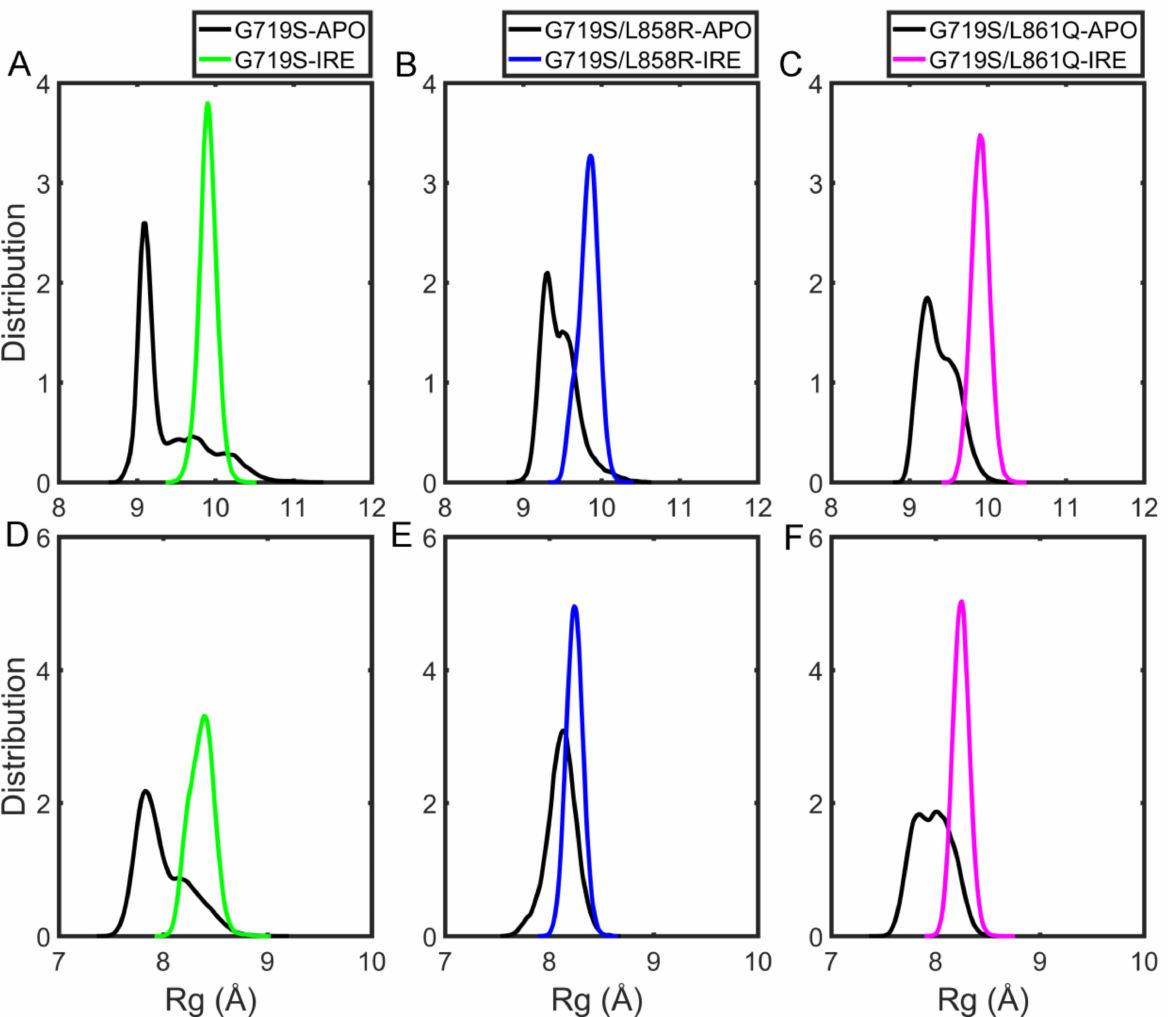
Figure 7. The probability distribution profiles of the R g values of the binding site in the six systems considering three replicates together: ( A ) G719S mutants; ( B ) G719S/L858R mutants; ( C ) G719S/L861Q mutants. The probability distribution profiles of the R g values of hydrophobic residues in the six systems considering three replicates together: ( D ) G719S mutants; ( E ) G719S/L858R mutants; ( F ) G719S/L861Q